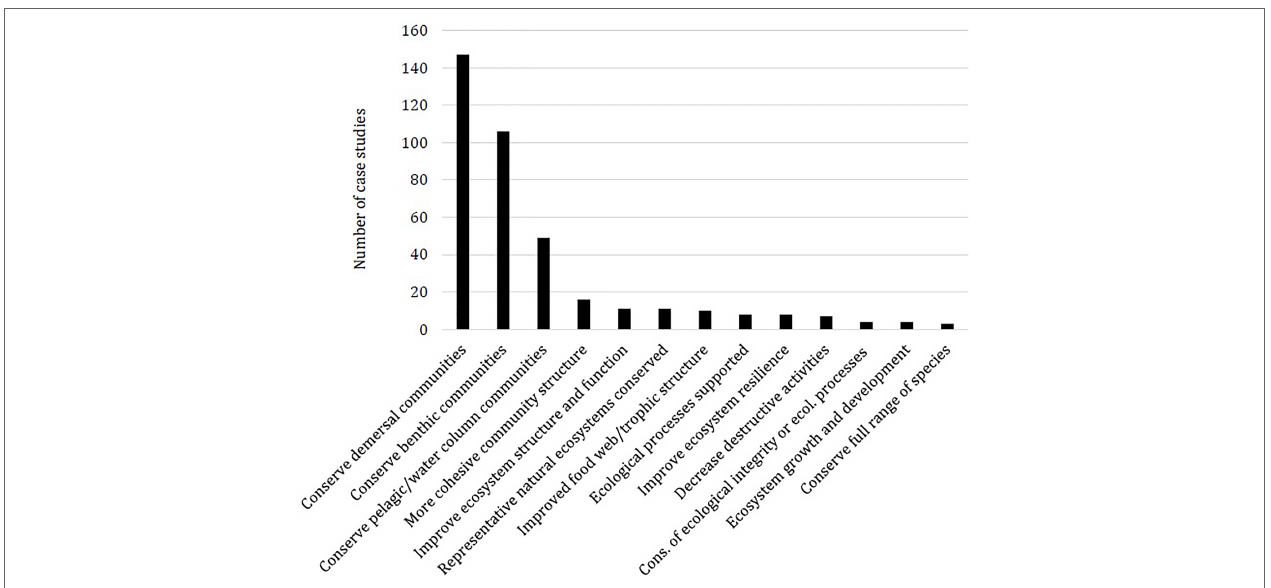
FIGURE 5 | Frequency of case studies for which ecosystem level biodiversity conservation outcomes were